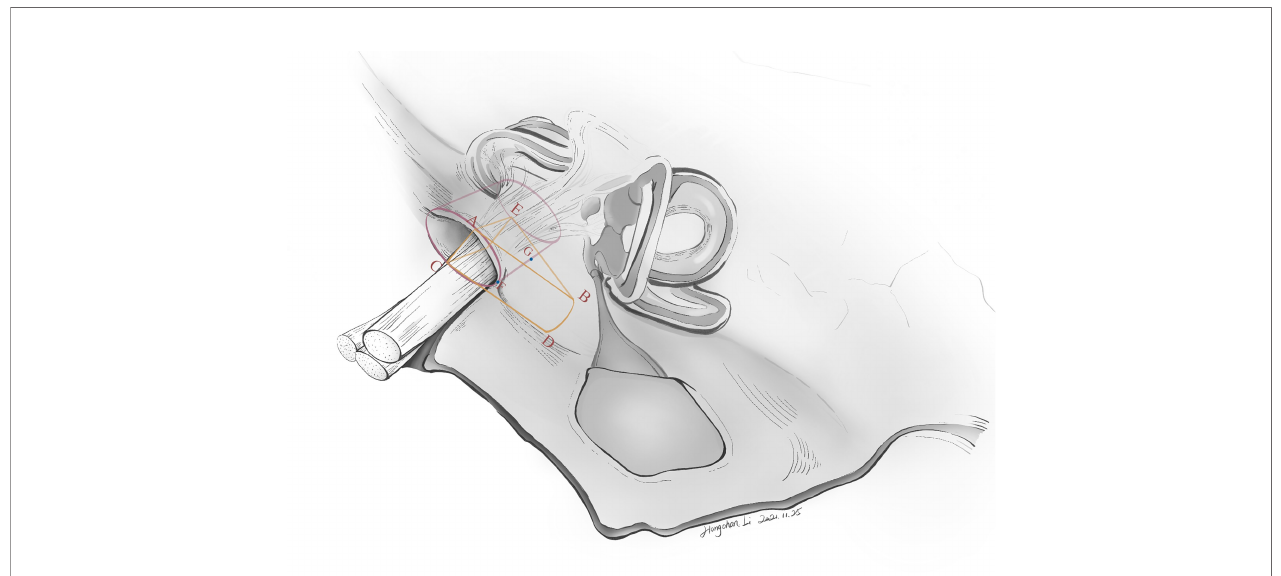
FIGURE 2 | The ideal drilling can maximize tumor exposure while avoiding injuries to neighboring structures (i.e., the bony labyrinth, the endolymphatic sac). To date, neither a standardized surgical planning nor a precise drilling method has been introduced to clinical practice. However, drilling the posterior wall of IAC is not an improvised technique but has fl exible rules to follow. The artist ’ s (Hongchan Li) illustration here shows several essential parameters in de fi ning the safe drilling range of the posterior wall of IAC. Lines AB and CD correspond to the “ entry borders ” of lateral drilling, which is approximately 12 – 14 mm in length. This means that approximately 12 – 14 mm of dura along the petrosal surface is incised, after identi fi cation of the Tübingen line. ∠ ABE is the drilling angle, usually 43 ˚ . Line GF denotes the length of the drilled posterior wall of IAC, which is about 8 mm in length. Line AE denotes the antero-superior border of the drilling range. Of note, these parameters are individualized to each